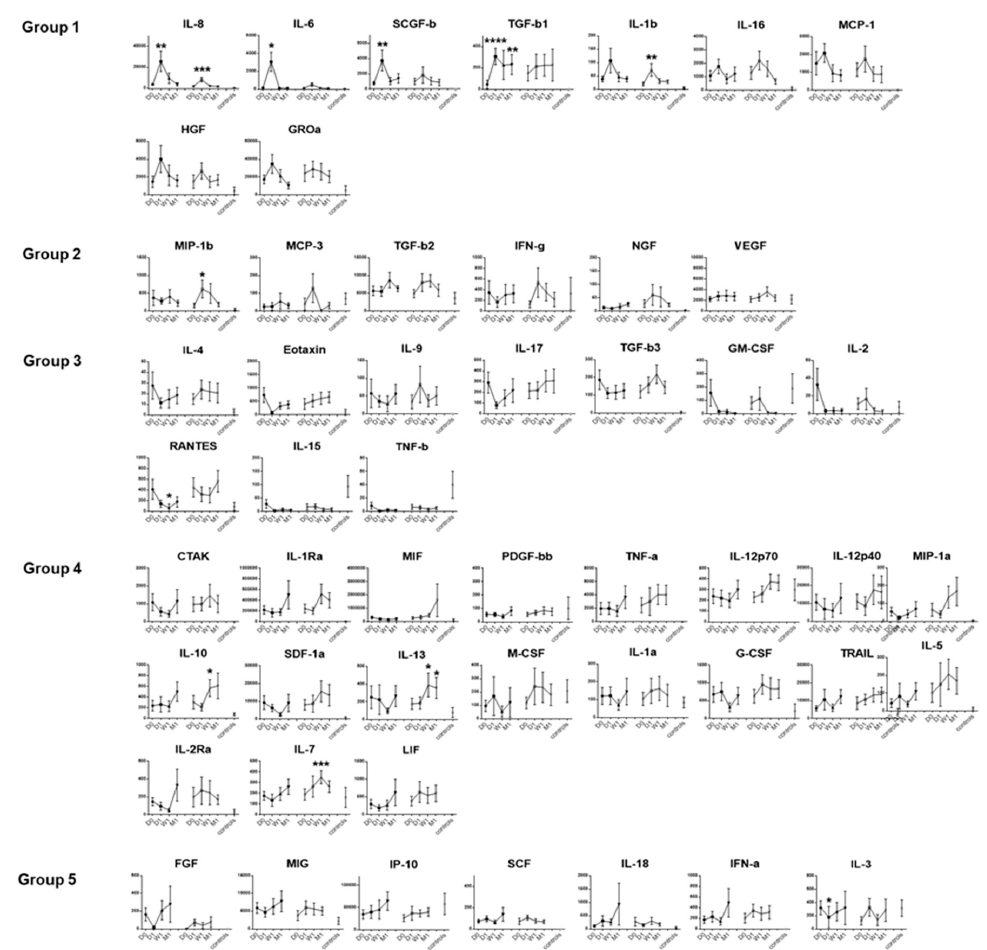
Figure 2. Dynamic change in tear fluid cytokines in bilateral eyes after EK. The mean ± SEM of tear protein levels at Day 0, Day 1, Week 1, and Month 1 time points are shown pairwise for the transplant and contralateral eyes in each plot for the 51 factors screened. Data shown are in pg/mL. The mean ± SEM are shown. * p < 0.05, ** p < 0.02, *** p < 0.01, **** p < 0.001.